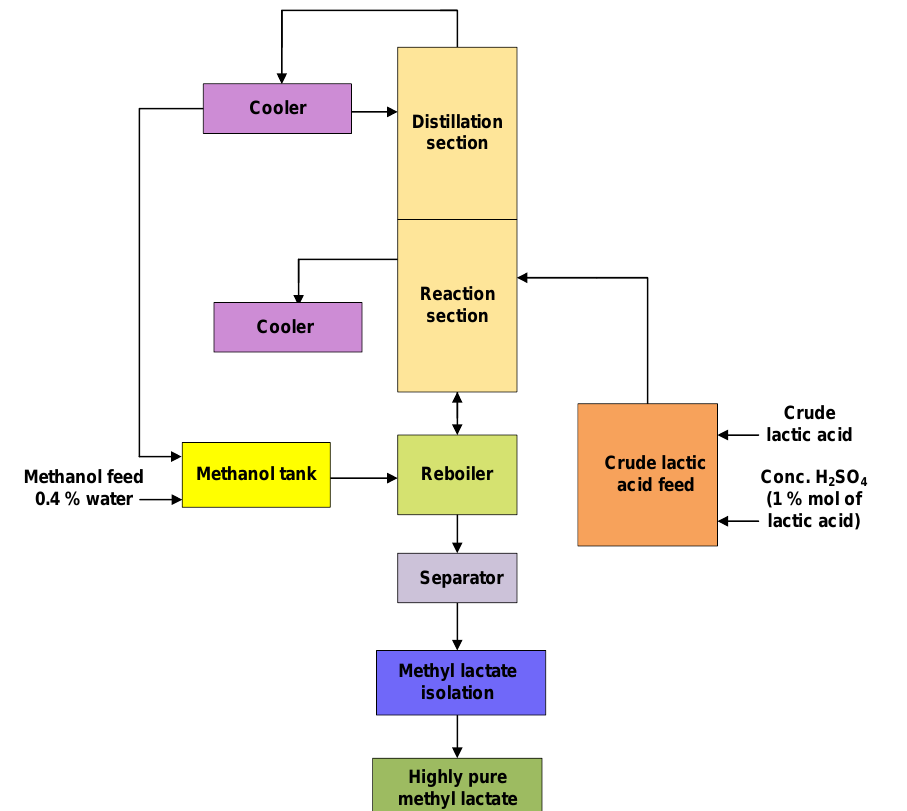
Figure 9. Block diagram for the second step of lactic acid purification that involves esterification of lactic acid with methanol in the presence of concentrated sulphuric acid forming methyl lactate (Adapted from Bapat et al. (2014) [189]).